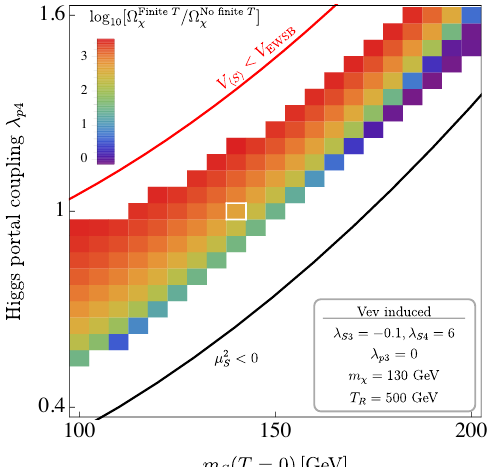
Figure 8 . The ratio of the DM abundance including (cid:12)nite temperature e(cid:11)ects to that ignoring (cid:12)nite temperature e(cid:11)ects in the vev-induced freeze-in scenario. We show a cut through the parameter space of the model in the plane spanned by the zero temperature mass of S , m S ( T = 0), and the quartic Higgs portal coupling (cid:21) p 4 . The white outline indicates the point considered in (cid:12)gure 7.